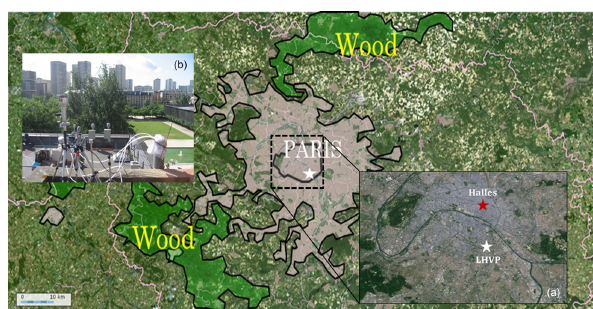
Figure 1. Maps of Paris and Île-de-France region. Panel (a) shows the location of the two main sampling sites in downtown Paris. The white and red stars locate the position of the LHVP laboratory and the AIRPARIF site, respectively. Panel (b) shows the terrace roof of